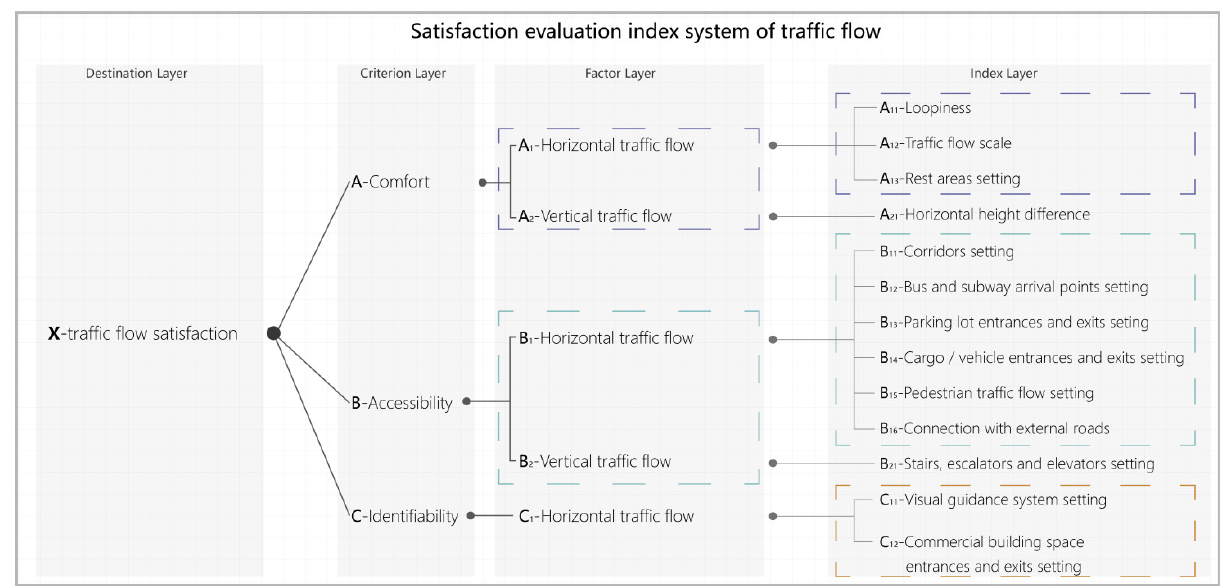
Figure 5. The satisfaction evaluation index system of Nanpu Times traffic flow design.